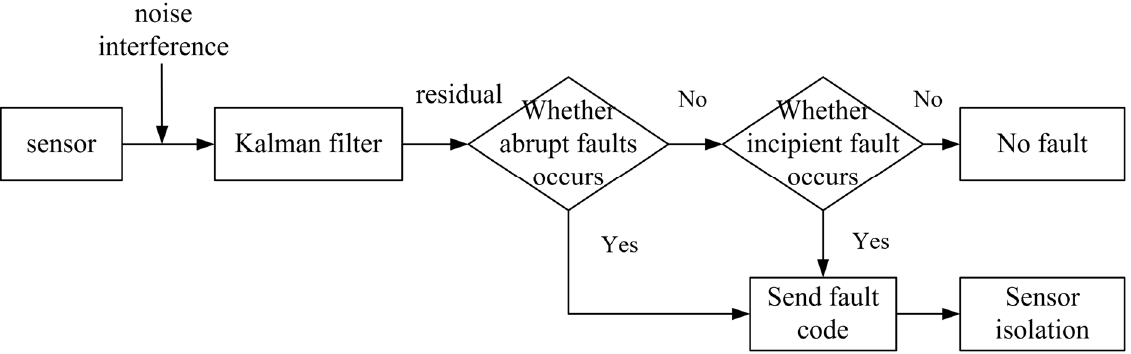
Figure 12. Flow chart of sensor fault diagnosis.